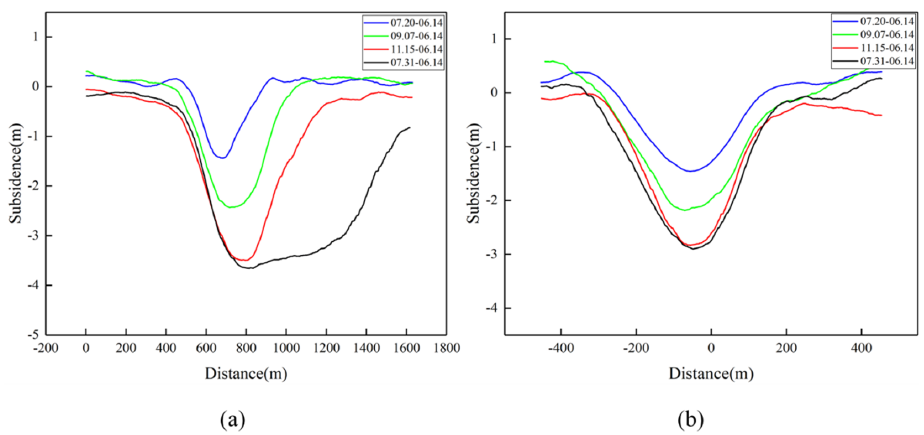
9 of 13 Figure 7. Curve fitting of subsidence and scattered points on the profile line: ( a ) strike 07.20 − 06.14; ( b ) strike 09.07 − 06.14; ( c ) strike 11.15 − 06.14; ( d ) strike 07.31 − 06.14; ( e ) dip 07.20 − 06.14; ( f ) dip 09.07 − 06.14; ( g ) dip 11.15 − 06.14; and ( h ) dip 07.31 − 06.14. It can be seen from Figure 8 that the maximum subsidence values for the strike and the dip increased regularly, and the subsidence velocity of the last data was reduced sig- nificantly compared with that of the previous three periods; also, the subsidence value was close to the maximum value under the geological mining conditions. In the time-se- ries strike subsidence curve, the area of maximum subsidence tended to move to the right, which was consistent with the direction of mining of the work face. The comparison be- tween the maximum subsidence value of the fitting curve and the measured value is shown in Table 5. The relative error between the fitted and measured value was not more than 20%, and the minimum value was 0.7%. Use of UAV photogrammetry to monitor the mining subsidence can reflect comprehensively the range of influence of mining subsid-